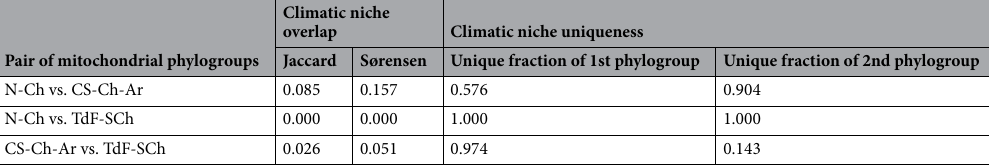
(Table 1). In this regard, both implementations of the Mantel tests based on climatic and geographic distances indicated that climatic differentiation of the genetic-sampled localities increases according to their geographic